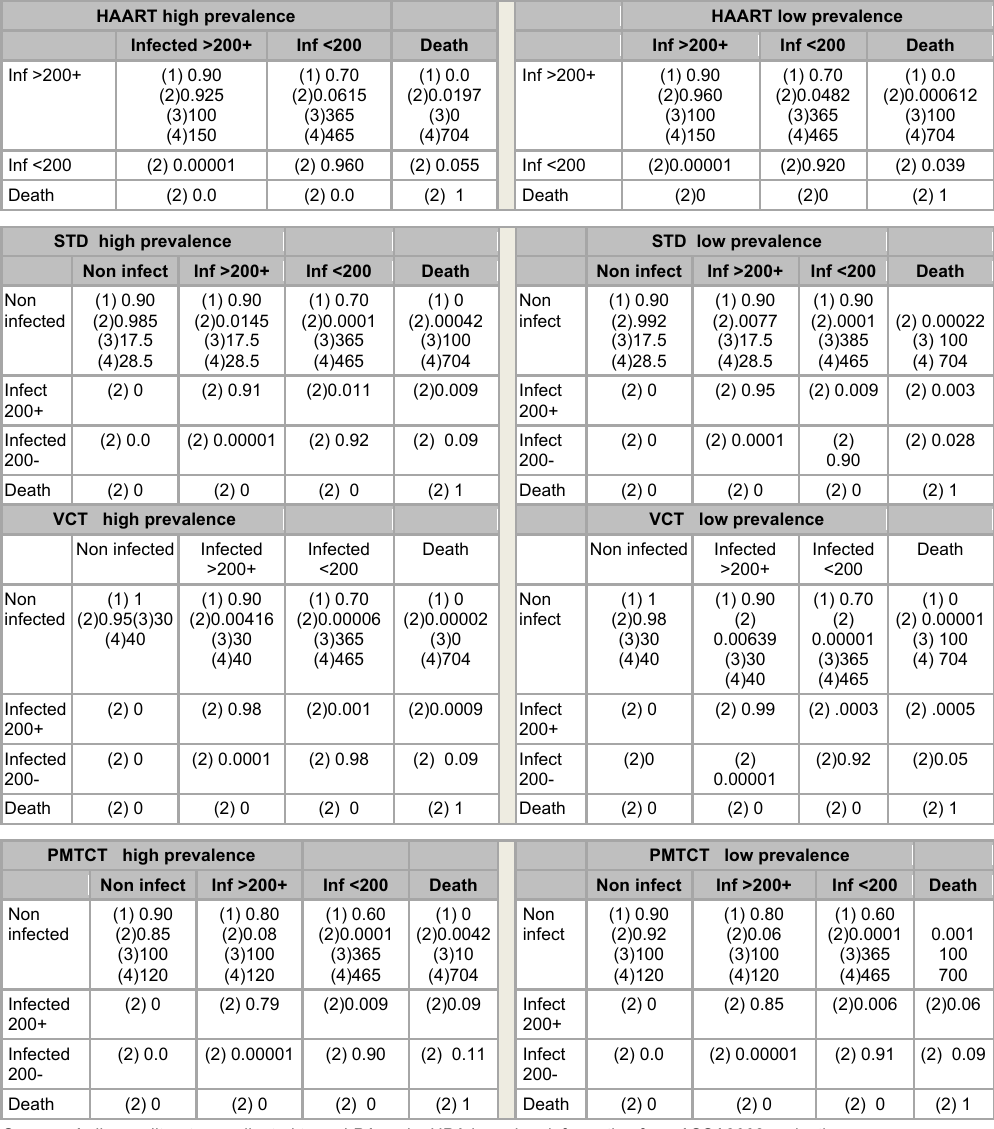
Quality of life (1), transition probabilities (2) government perspective costs (3) and societal perspective costs (4) for the first 3-month